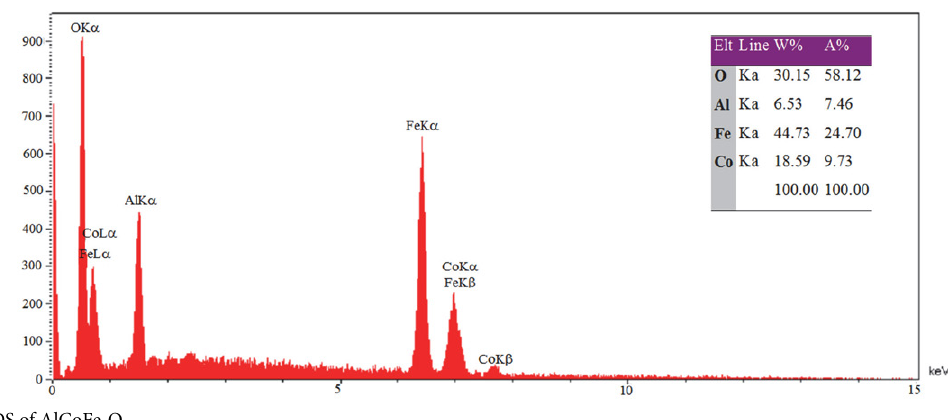
Figure 2. EDS of AlCoFe 2 O